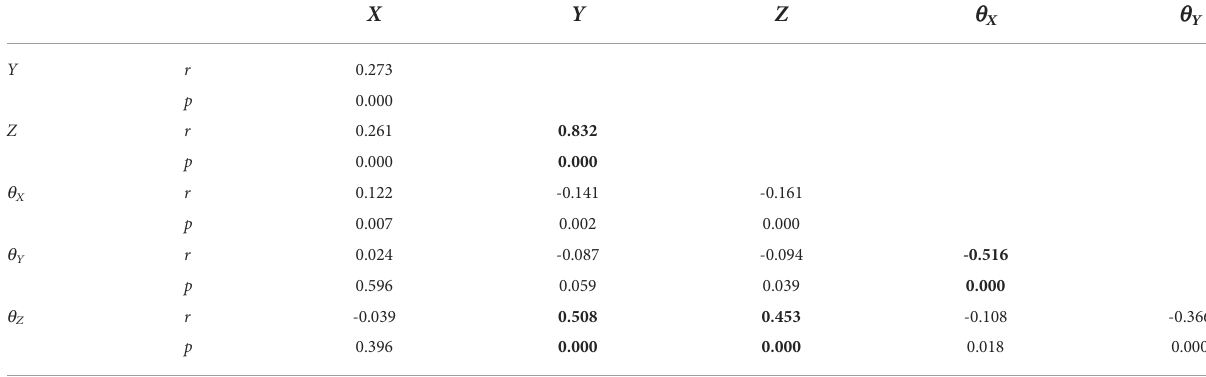
TABLE 3 Pearson ’ s correlation coef fi cient between six dimensional movements of translation and